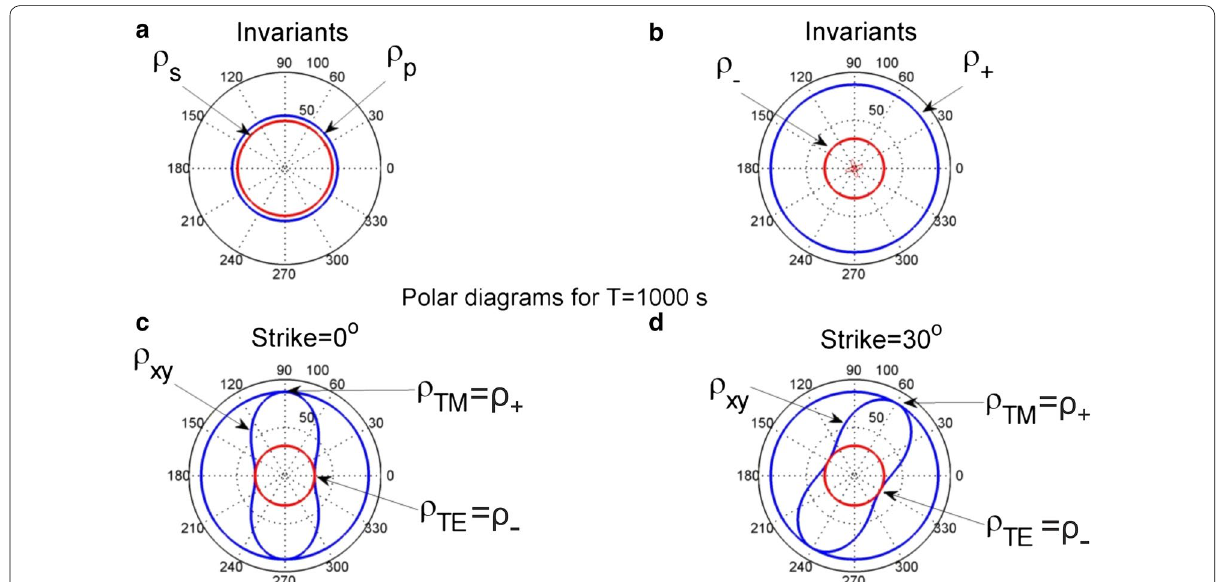
and ρ ; c the element ρ xy for a strike of 0° and the invariants ρ + − and ρ +